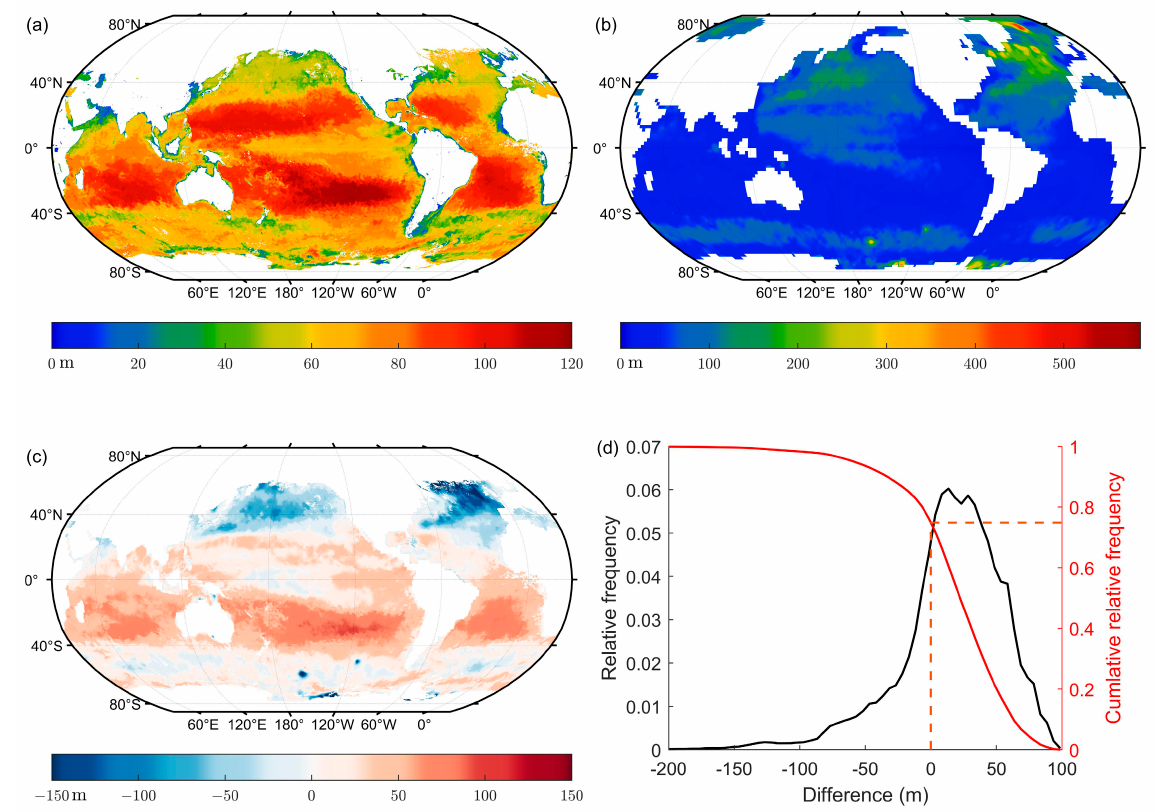
Figure 24. Comparison between lidar maximum detectable depth and MLD in the winter (the northern hemisphere). Distribution of the lidar maximum detectable depth at daytime ( a ), mixed layer depth ( b ), the difference between lidar maximum detectable depth and mixed layer depth ( c ), and the relative frequency distribution of the difference ( d ).